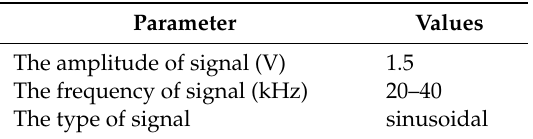
Table 1. The parameters of the excitation signal for simulation.